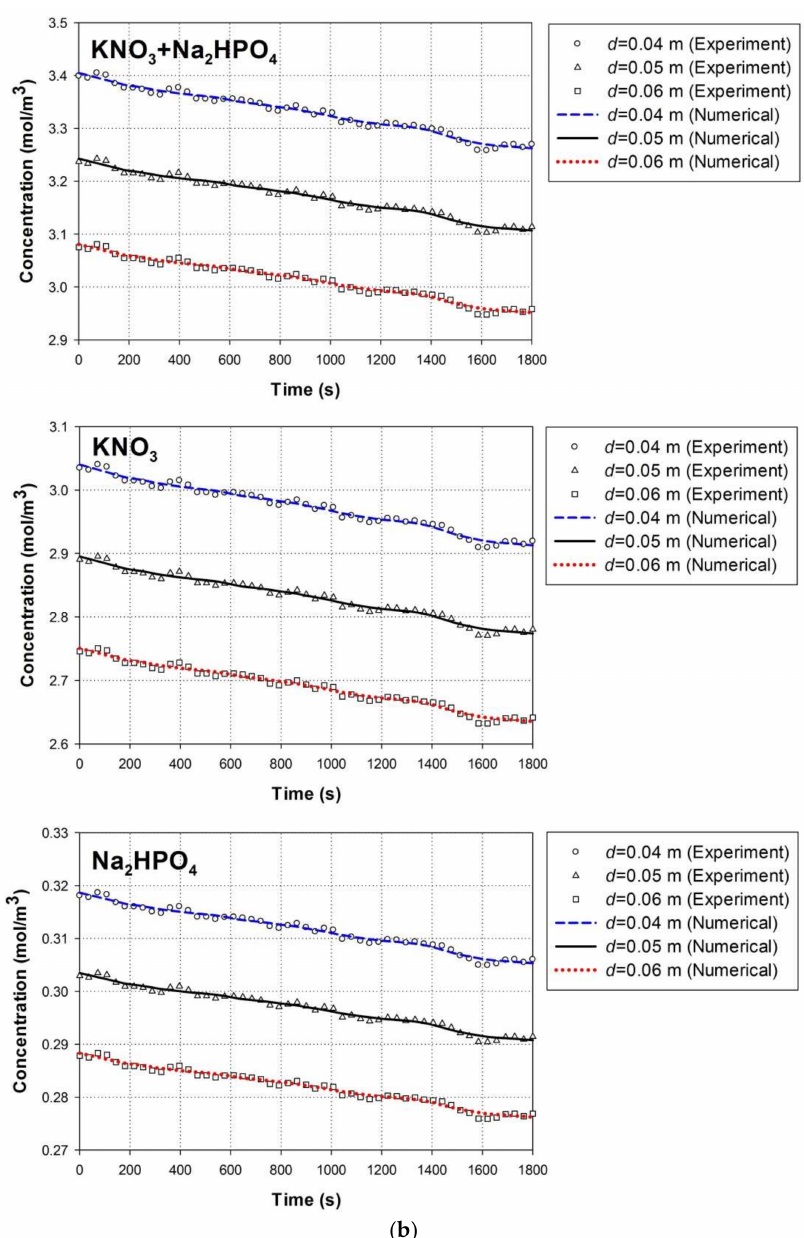
Figure 4. Comparison of the experimental and numerical results of nutrient concentrations with the effects of different ( a ) paddle wheel speeds and ( b ) water